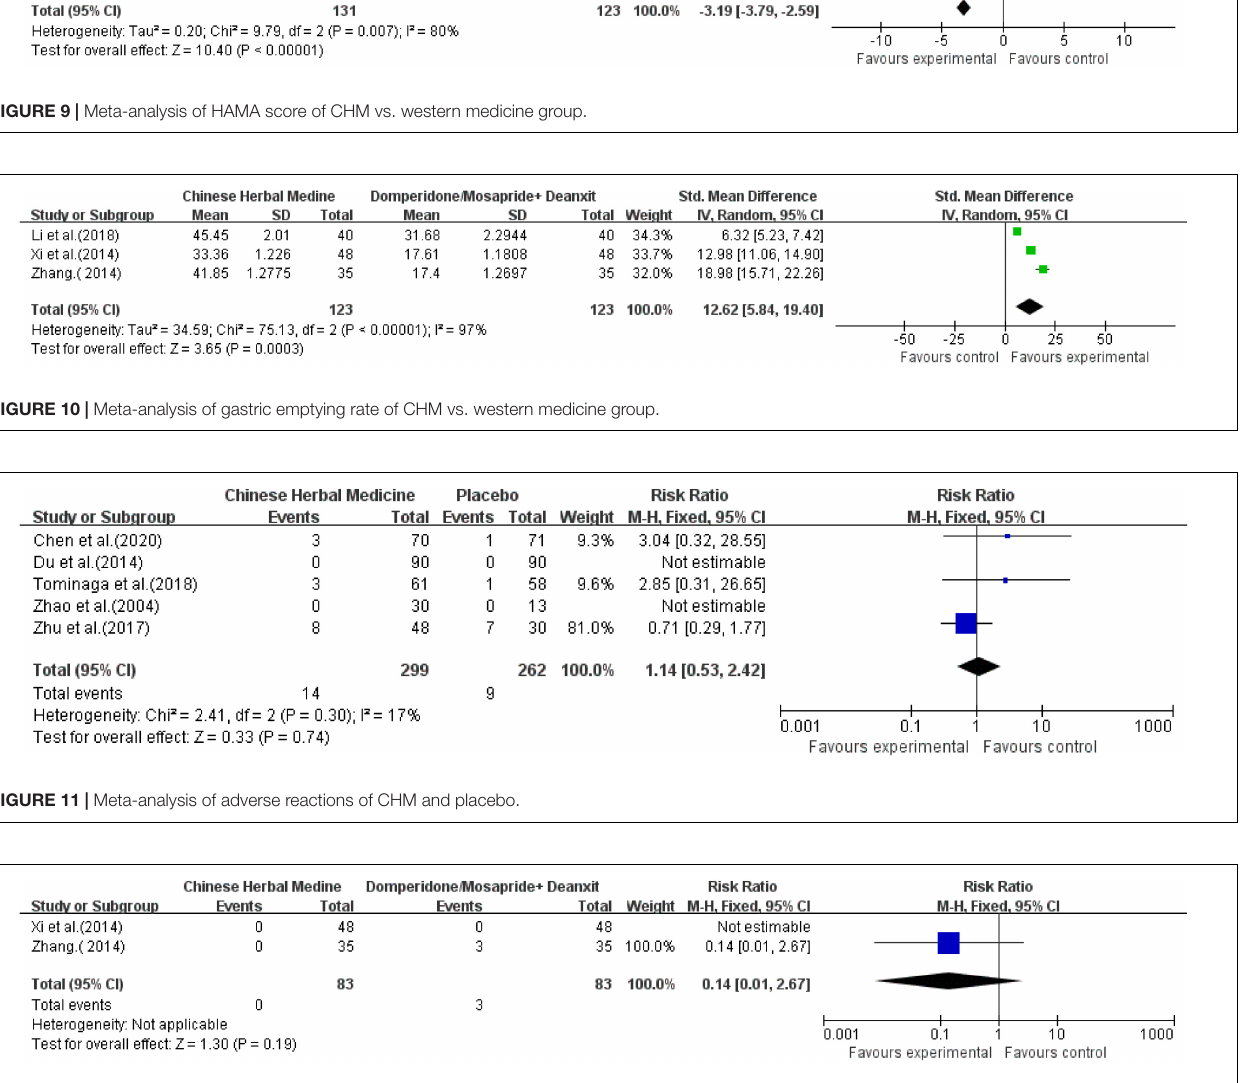
FIGURE 12 | Meta-analysis of adverse reactions of CHM vs. western medicine